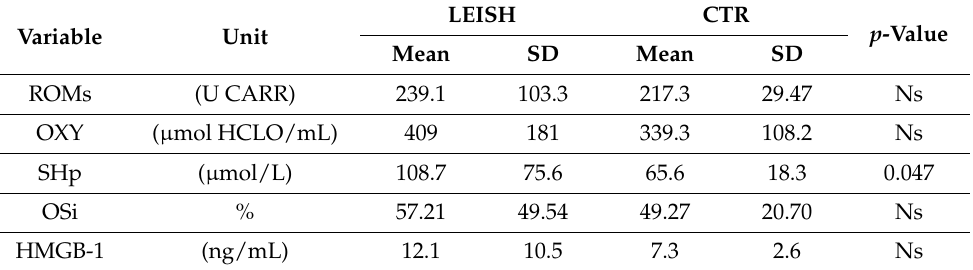
Table 2. Concentration of HGMB-1 (High Mobility Group Box-1 protein), ROMs (reactive oxidative metabolites), OXY (antioxidant barrier), SHp (thiol groups of plasma compounds) and OSi (ratio between ROMs and OXY) in the serum of dogs affected by CanL (LEISH Group) and in control (CTR Group).